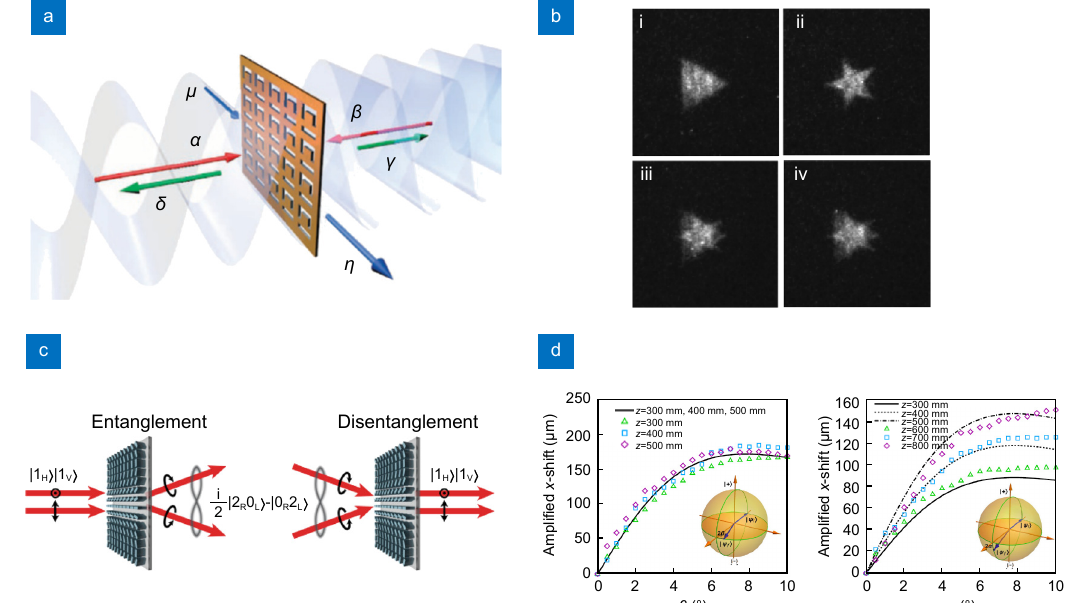
Fig. 3 | Quantum photonic applications based on metasurfaces. ( a ) Absorption of single photon based on metallic metasurfaces, α and β represent two photon input channels, δ and γ represent two photon output channels, μ and η represent plasmonic input and output channel re- spectively. ( b ) Figure i and ii use signal photon of photon pair to image the metasurface, projective measurements on idle photon is carried out to clearly distinguish triangle and star pattern. Figure iii and iv use photons of mixed state to image metasurface which cannot distinguish the two patterns. ( c ) Metasurface is used to entangle and disentangle two photon NOON state. ( d ) The position shift and momentum shift of photon wavefunction induced by quantum weak measurement based on metasurfaces. Figure reproduced from: (a) ref. 93 , Springer Nature; (b) ref. 96 , American Physical Society; (c) ref. 98 , Springer Nature; (d) ref. 99 , AIP